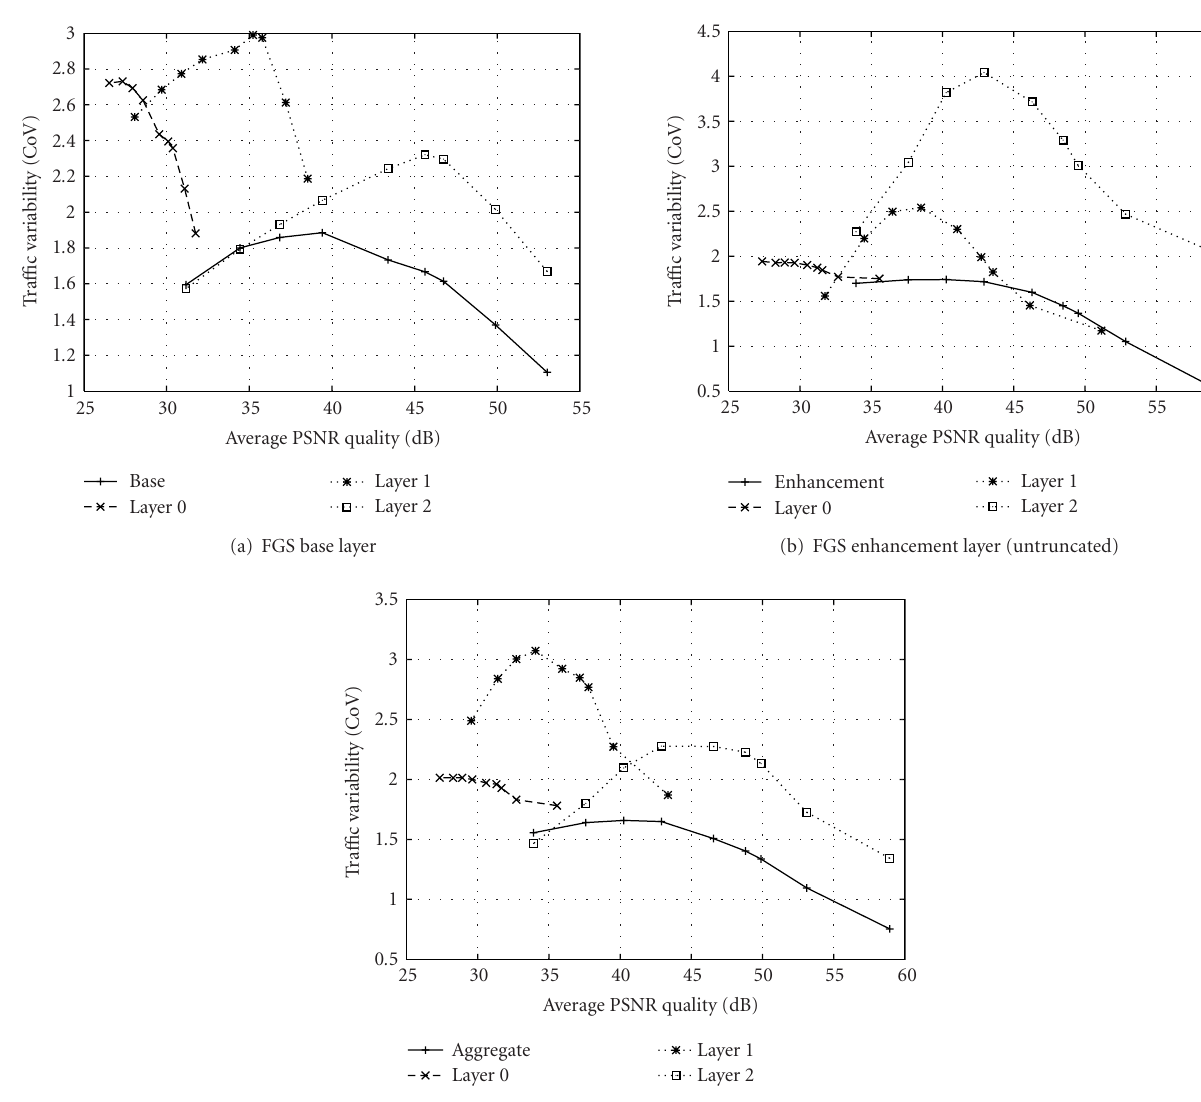
Figure 12: VD curves of all temporal layers ( 0 , 1 , 2 ) embedded in each FGS layer and in the aggregated (base + untruncated enhancement) tra ffi c stream, for the Star Wars IV sequence encoded with SVC FGS ( G16-B3